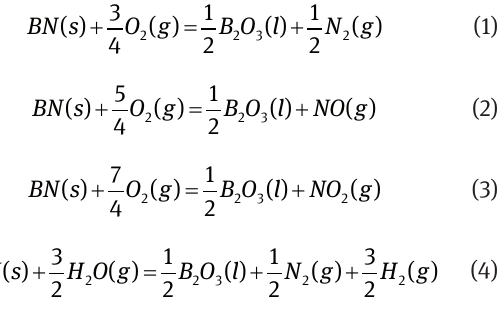
Table 1: The ratio of H 2 O to air at room